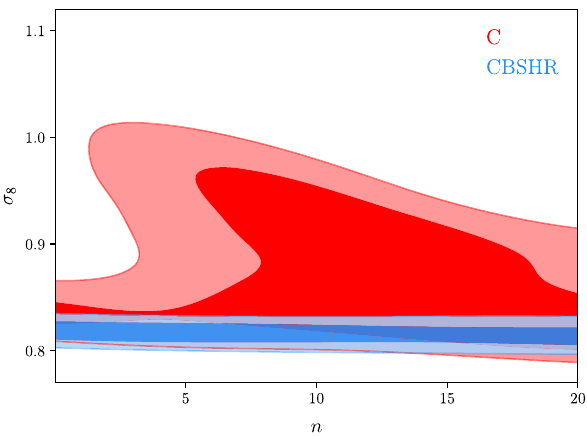
Fig. 4 The constrained 2-dimensional parameter spaces (log 10 f R 0 , σ 8 ) from the data combination “CBSHR” are shown for HS f els with n = 1 (red) and free n (blue), respectively. The magenta dashed line denotes log 10 f R 0 = − 6